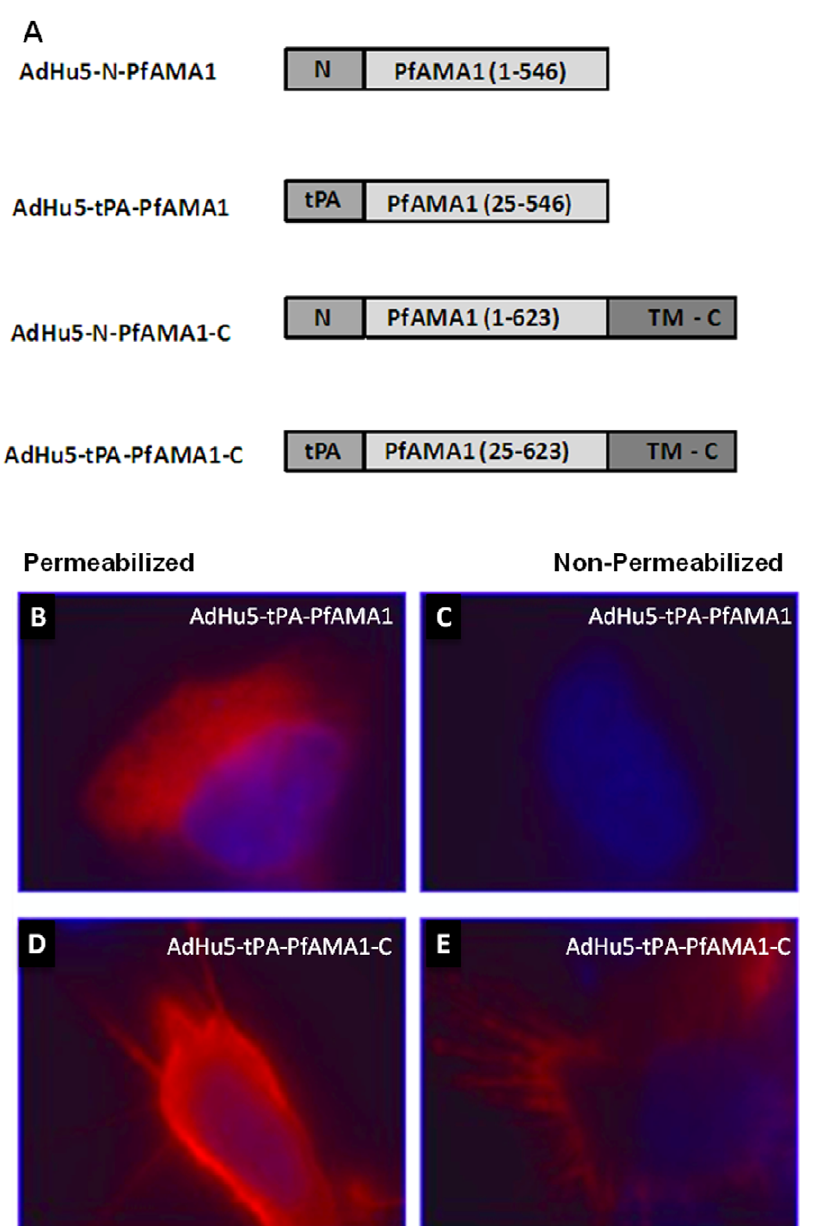
Figure 4. Schematic representation of the different PfAMA1 (3D7) constructs and effect of the addition of the C terminus on cellular localization of PfAMA1. (A) The figure shows the different AdHu5 vaccine inserts generated to test the effect of replacing the human tPA leader sequence with the native AMA1 N-terminal predicted signal peptide (aa 1–24) and also the effect of addition of the native transmembrane domain and C-terminal cytoplasmic domain (aa 547–623). PfAMA1 in this figure represents the ectodomain of P. falciparum 3D7 AMA1 (aa 25–546). Hela cells were grown on cover slips and transfected with the plasmid encoding tPA-PfAMA1 (B and C) or tPA-PfAMA1-C (D and E). After overnight incubation polyclonal serum from immunized mice was used to detect the localization of PfAMA1. Alexa-conjugated anti-mouse antibody was used as the secondary antibody and the DNA was stained with 4 9 , 6-diamidino-2-phenylindole (DAPI). Cell surface localization of PfAMA1, notably on the cell projections, was seen in the construct that has the C terminal domains in both the permeabilized (D) and non-permeabilized samples (E). There is no cell surface associated PfAMA1 in the construct without the C terminal domains (B and C).